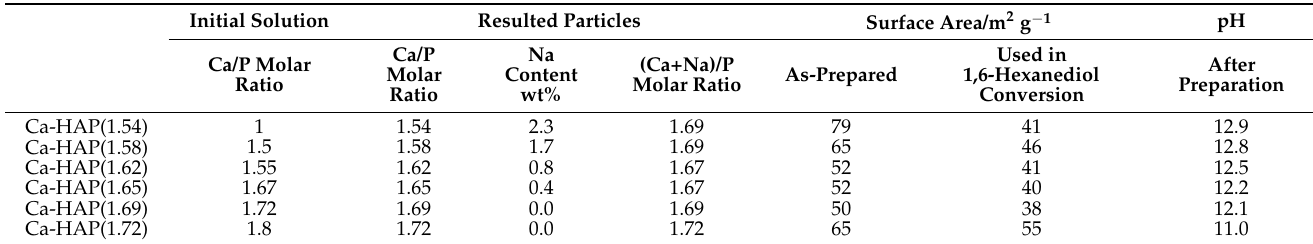
Table 1. Characterizations of prepared hydroxyapatite